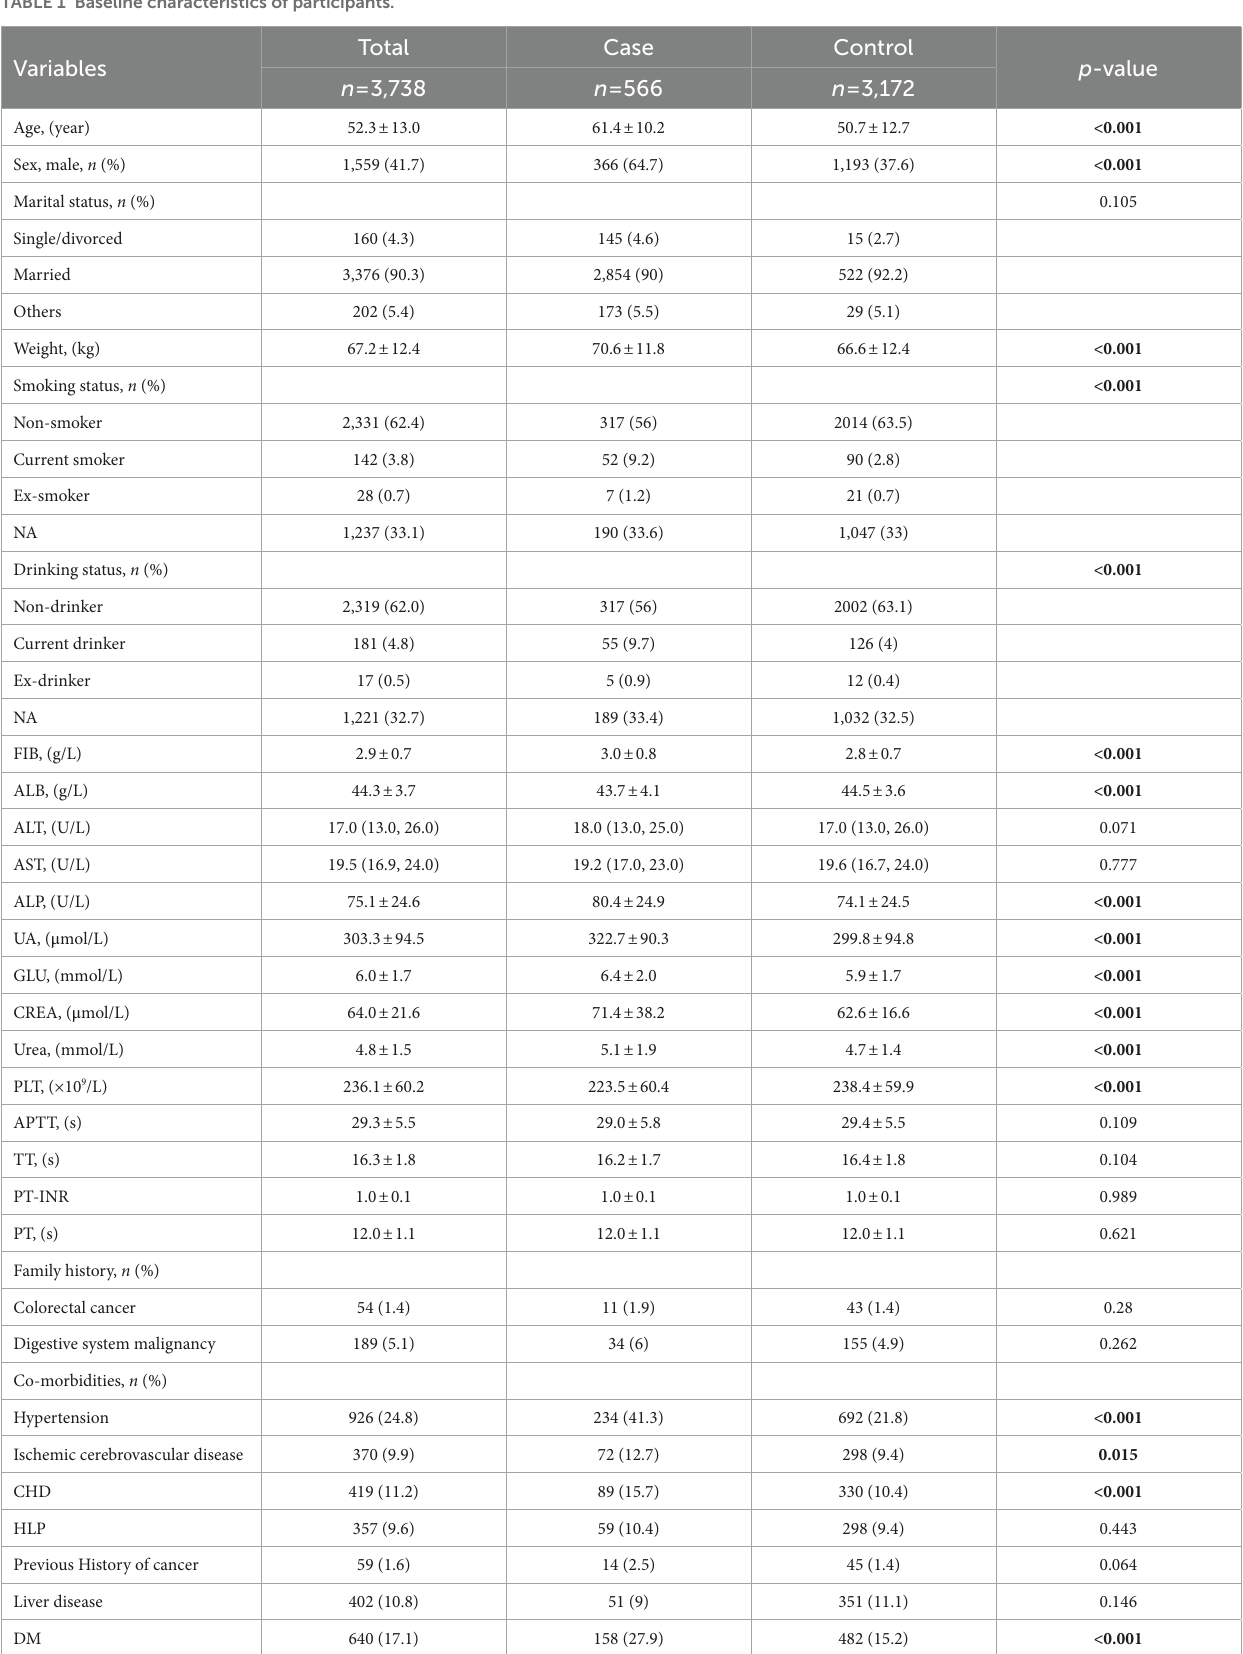
TABLE 1 Baseline characteristics of